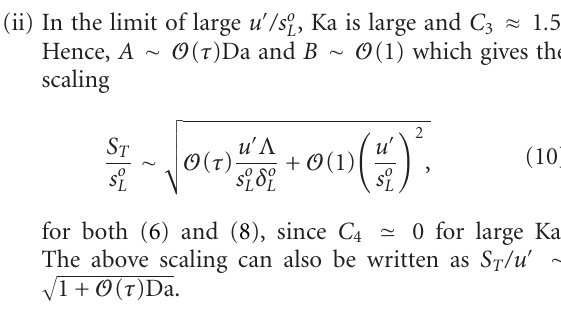
(ii) In the limit of large u (cid:2) /s o L , Ka is large and C 3 ≈ 1 .